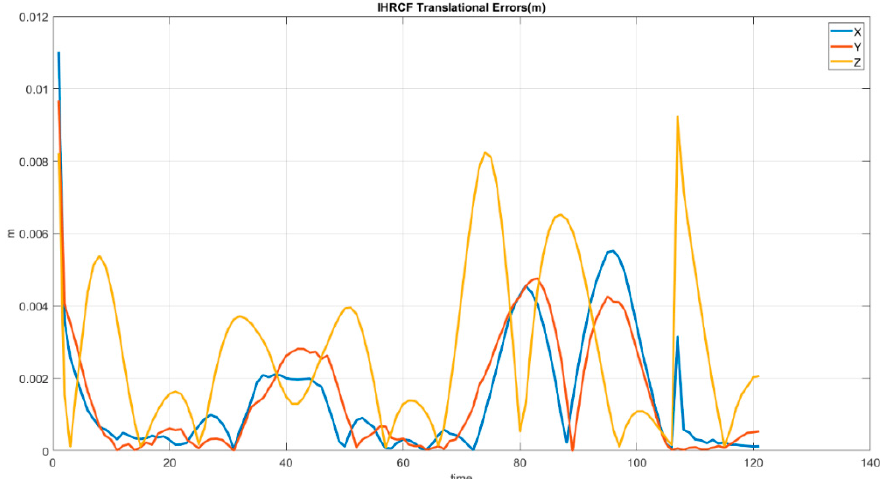
Figure 17. IHRCF-based Stewart platform Euler angles estimation error along the X (blue), Y (red), and Z (yellow) axes.